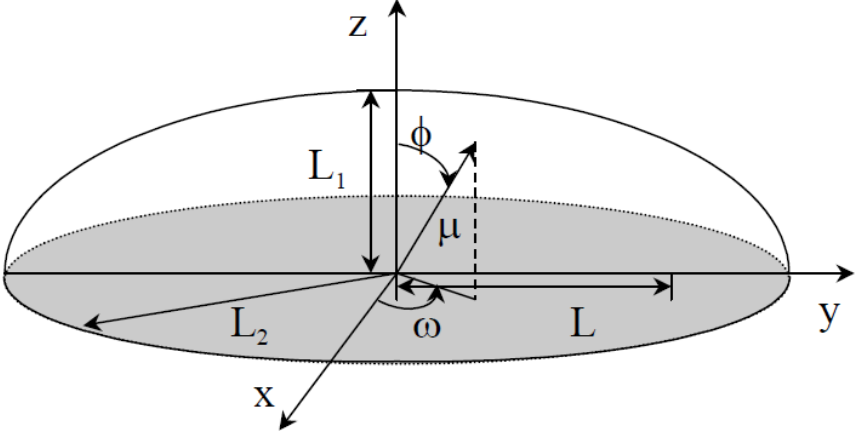
Figure 1. Features of an oblate spheroidal body.